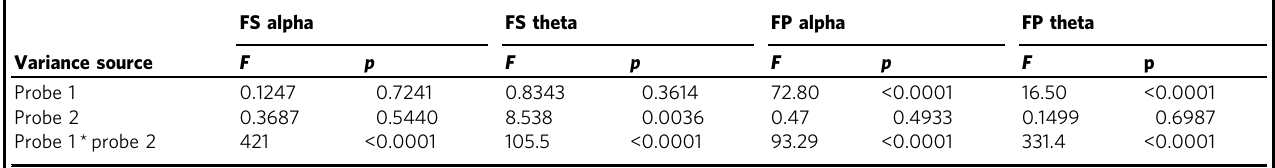
Table 2 the ANOVA results of